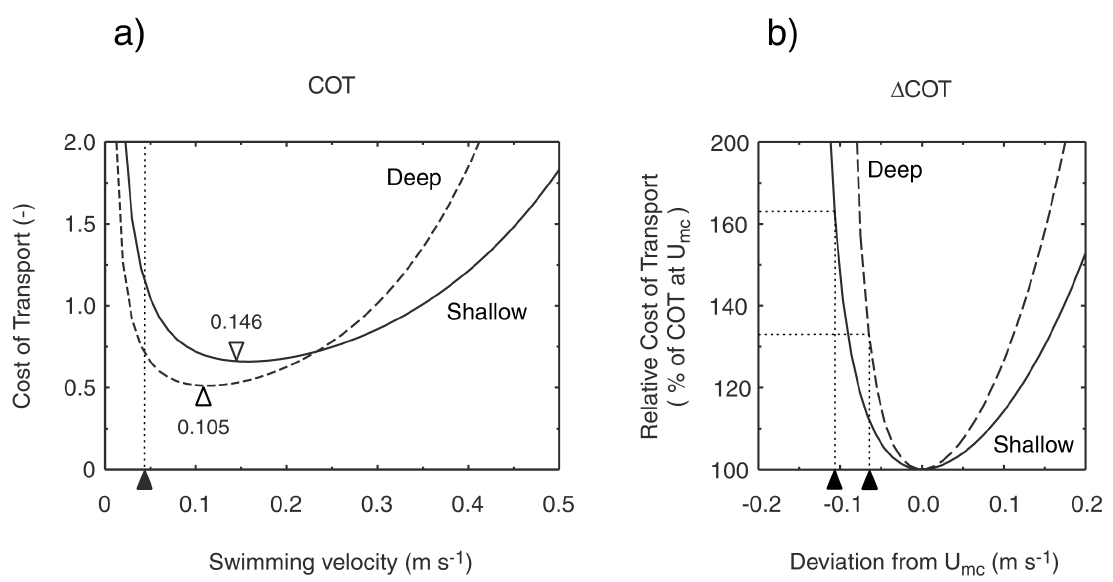
Fig. 4. Cost of transport (COT) and relative cost of transport ( ∆ COT) for shallow-bodied and deep-bodied crucian carp. (a) cost of transport as a function of swimming velocity. The metabolic cost for the shallow-bodied morph is P(U) = 0.0044 × e 6.84 × U (solid line, denoted shallow), and for the deep-bodied morph: P(U) = 0.0035 × e 9.56 × U (broken line, denoted deep). Masses used in calculations are 11.9 g (shallow-bodied morph) and 17.0 g (deep-bodied morph). Dotted line denotes average swimming velocity U for the two morphs. In (b), velocities have been standardised to U and the relative cost of transport ( ∆ COT) for average individuals of the two mc morphs is shown as a function of the deviation from U . Solid line (shallow) denotes the shallow-bodied morph and the broken line mc and associated relative costs of transport ( ∆ COT) for (deep) denotes the deep-bodied morph. Dotted lines denote deviations from U mc the two